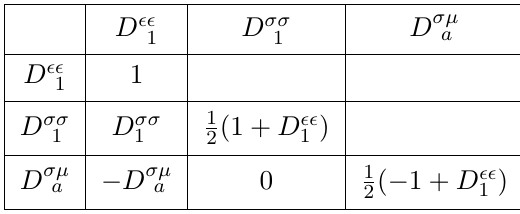
Table 10 . Interface sewing constraints for an interface between the standard and fermionic Ising